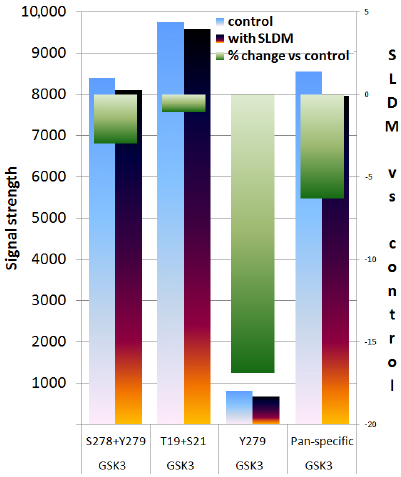
Figure 3. Protein array of GSK3 changes in ovarian cells after treatment with SLDM . Signal strength, indicative of expression, for GSK ‐ 3 in SKOV ‐ 3 cells treated with SLDM was reduced when compared to the control. Furthermore, all the phosphorylation sites analysed on the protein array (S278, Y279, T19 and S21) were also reduced in signal strength compared to the untreated control. The green bars indicate the changes in signal strength as a representative of percentage control.